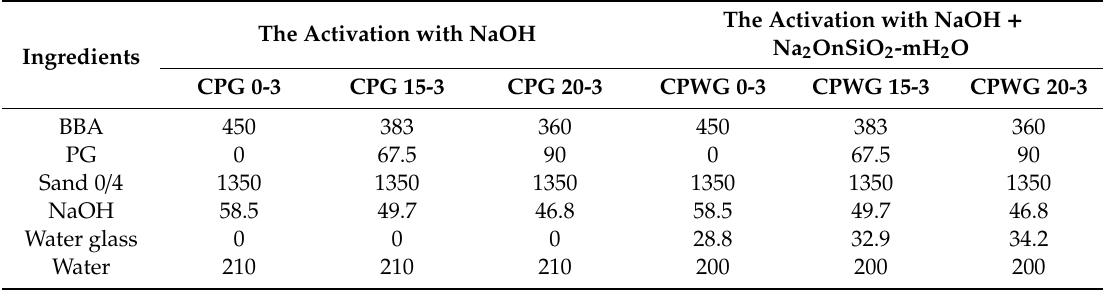
Table 3. Mixing composition of alkali activated biomass bottom ash concrete,